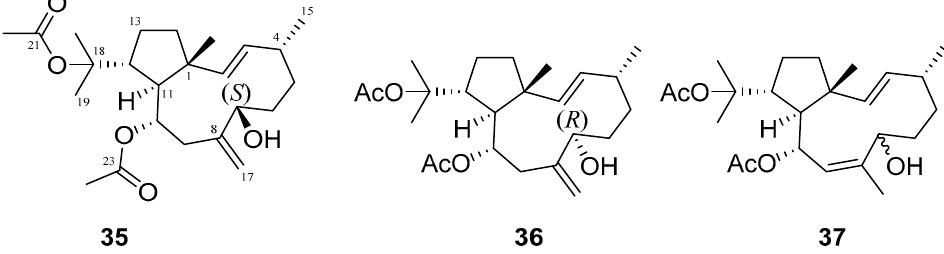
Figure 15. Structures of the new dolabellane diterpenoids dolabelladienols A–C ( 35 – 37 ).